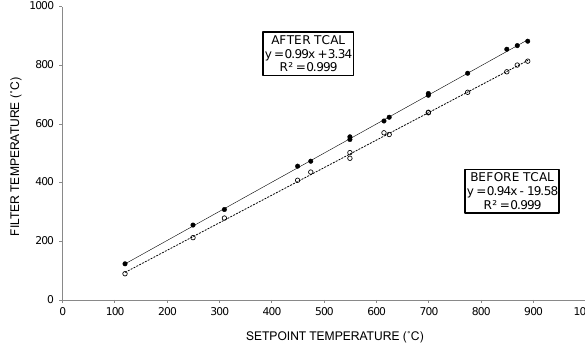
Figure 1. Linear regression results before and after temperature cal-